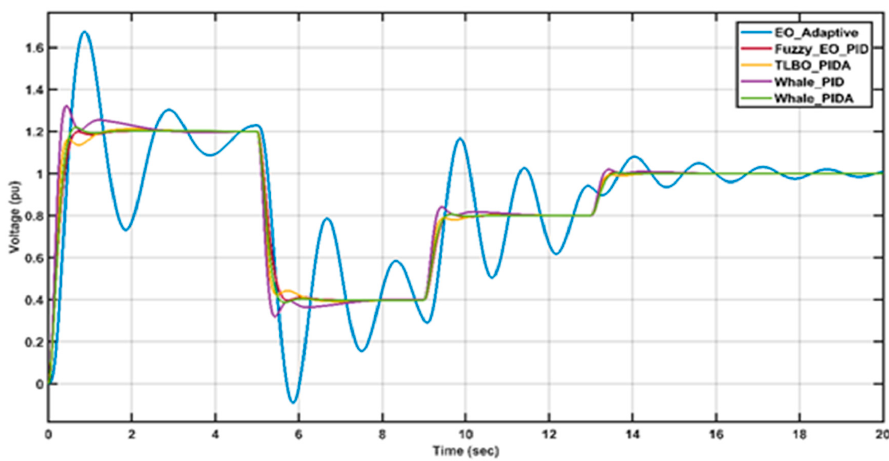
Figure 14. Dynamic voltage reference for simple AVR model.